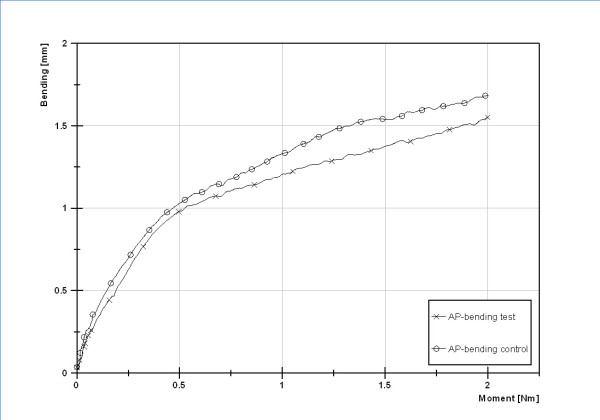
Control cycle of testing to check for possible destructive changes which could have influenced the results.